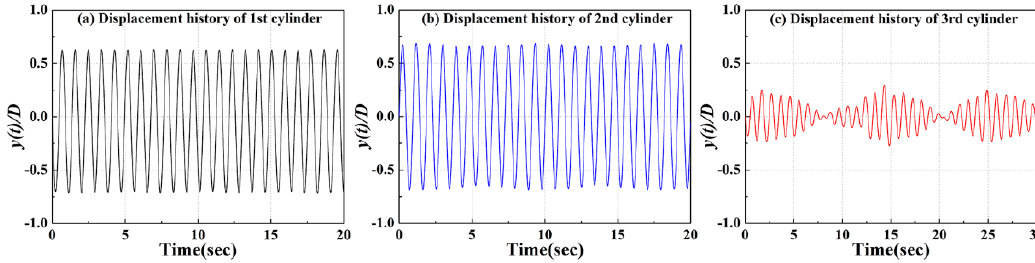
Figure 9. Time history curves of displacement for three cylinders when Re = 30,000.